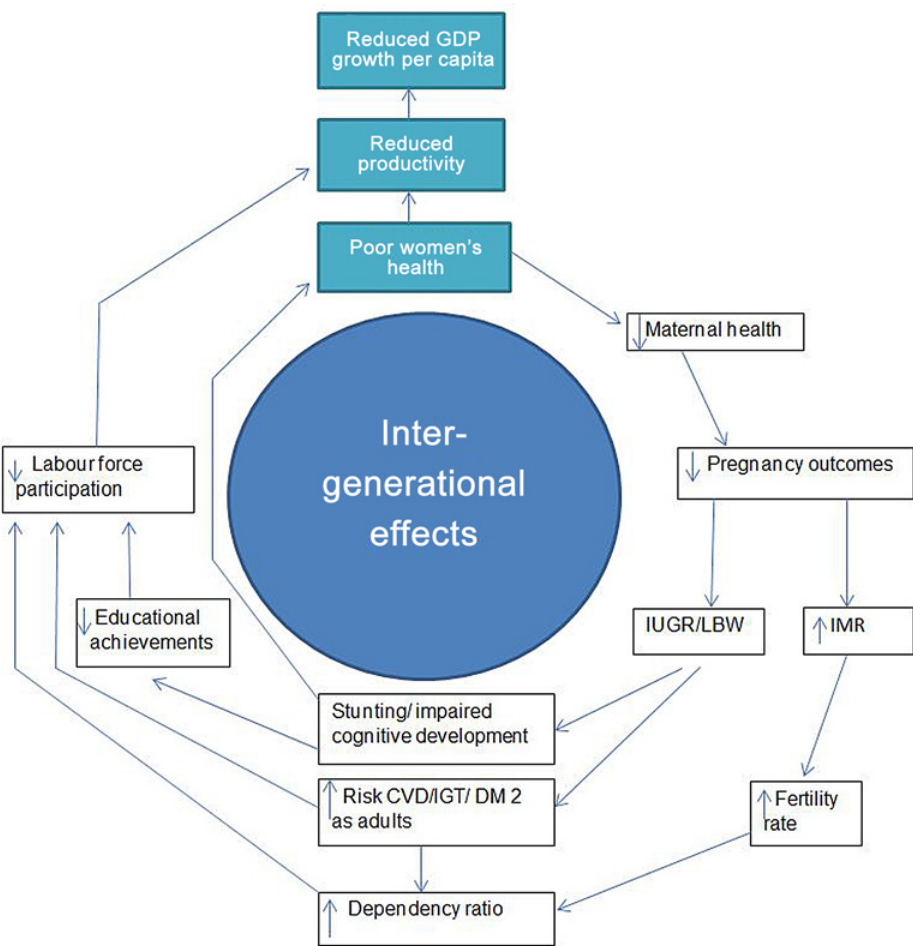
Fig 2. The virtuous spiral of intergenerational health effects. Fig abbreviations: IMR: infant mortality rate, IUGR: Intrauterine growth restriction, LBW: low birth weight, CVD: cardiovascular disease, IGT: impaired glucose tolerance, DM2: diabetes mellitus type